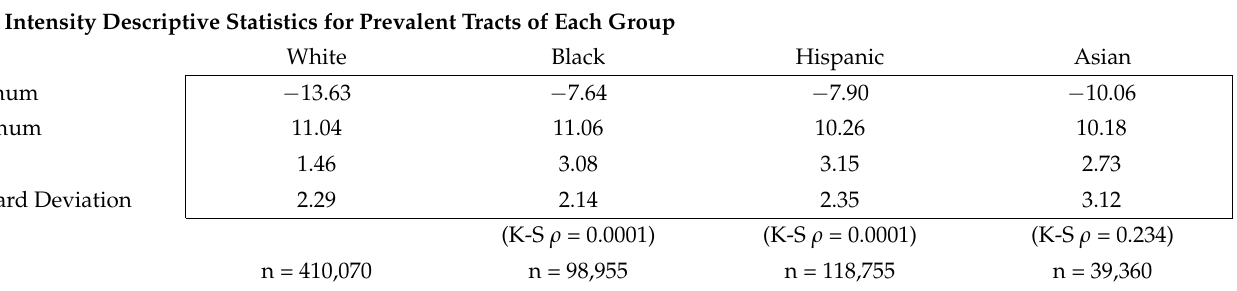
Table 2. Descriptive statistics of SUHI intensity within group-based prevalent tracts.